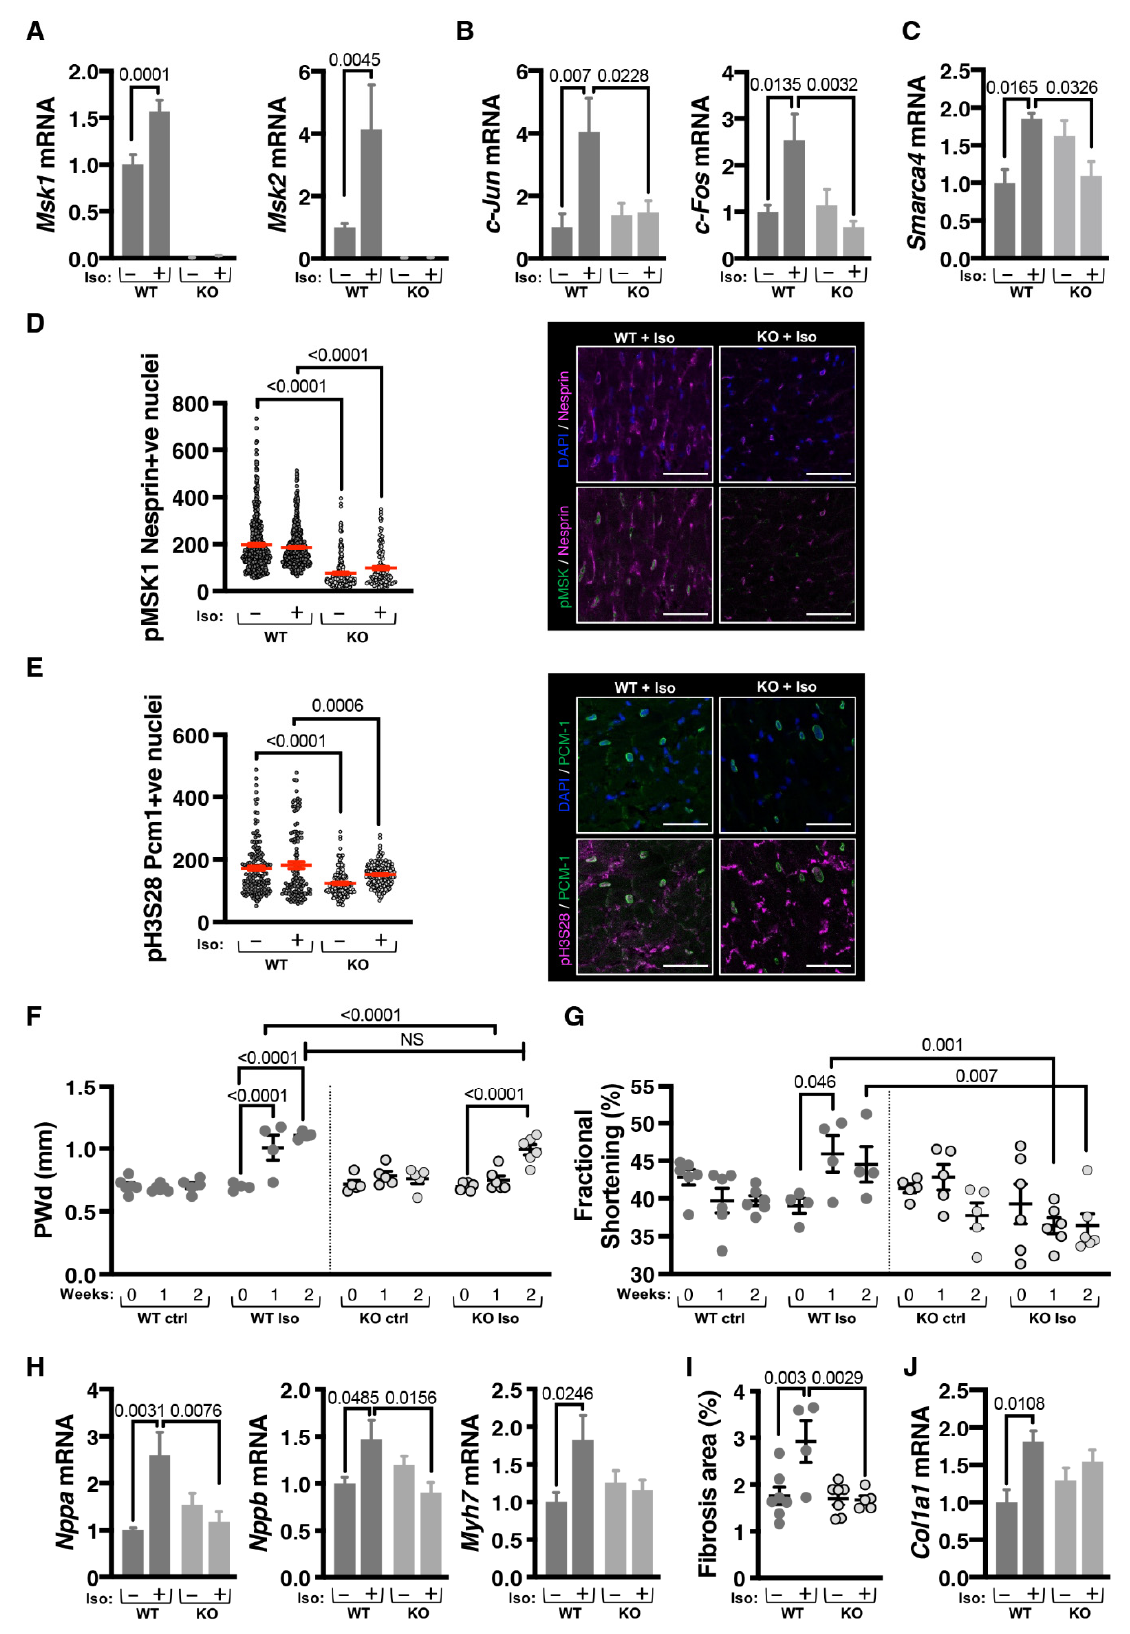
Figure 3. IEG activation and cardiomyocyte hypertrophy is suppressed in vivo in MSK1/2 KO mice. ( A ). RT-qPCR analysis of Msk1 ( Left ) and Msk2 ( Right ) mRNA expression in left ventricle from